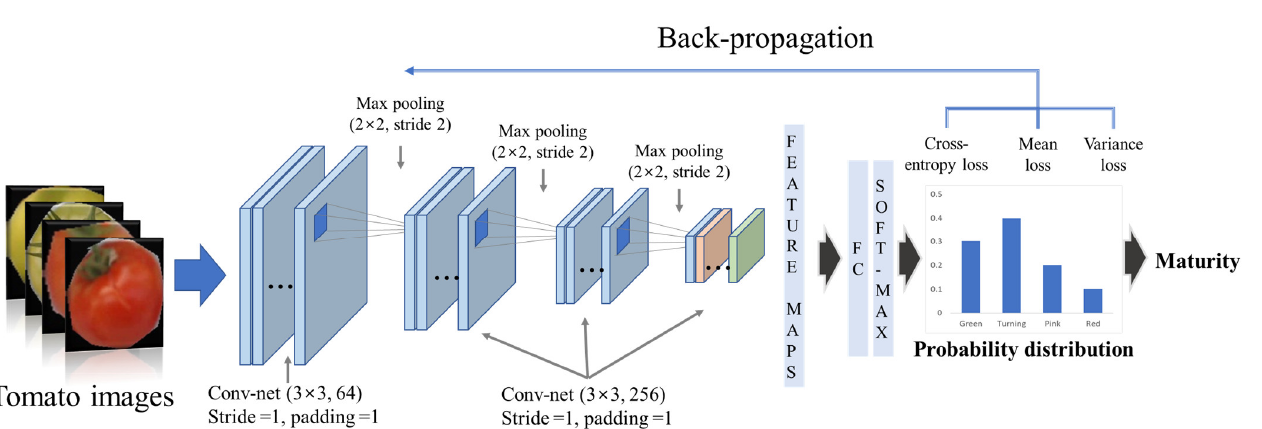
Figure 3. Model structure of DNN for tomato maturity estimation. The model has a shallow 4-CNN architecture with a practical processing speed, and mean and variance losses are added to learn the tomato maturity distribution within a class. The output of softmax is calculated as the argmax value for the training stage and the estimated value of the maturity level for the test stage.